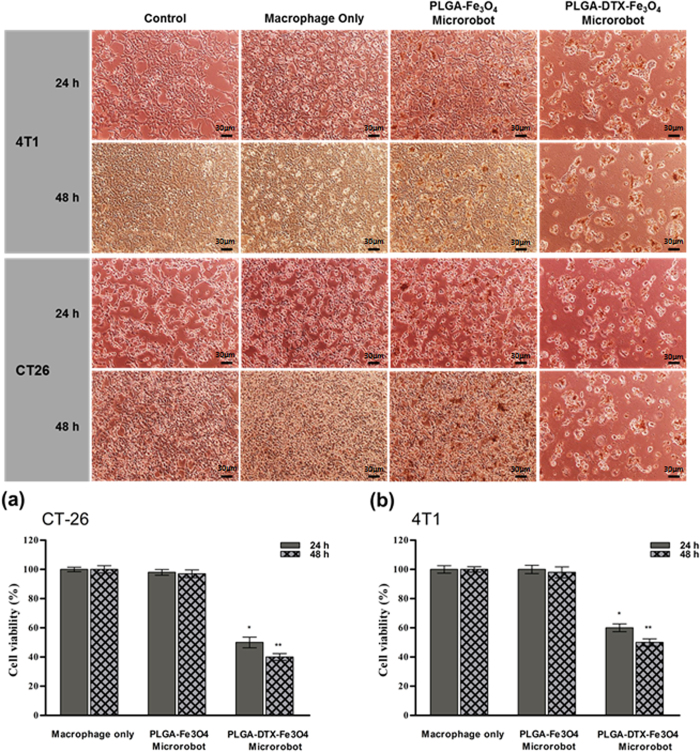
Chemotherapeutic effects of macrophage-based microrobots.(Top) Microscopy images of tumor cell lines treated with macrophage-based microrobots with PLGA-DTX-Fe3O4 (Scale bar 30 μm). (Bottom) Quantification of cytotoxicity macrophage-based microrobots with PLGA-DTX- Fe3O4 against cancer cell lines ((a) 4T1, (b) CT-26).